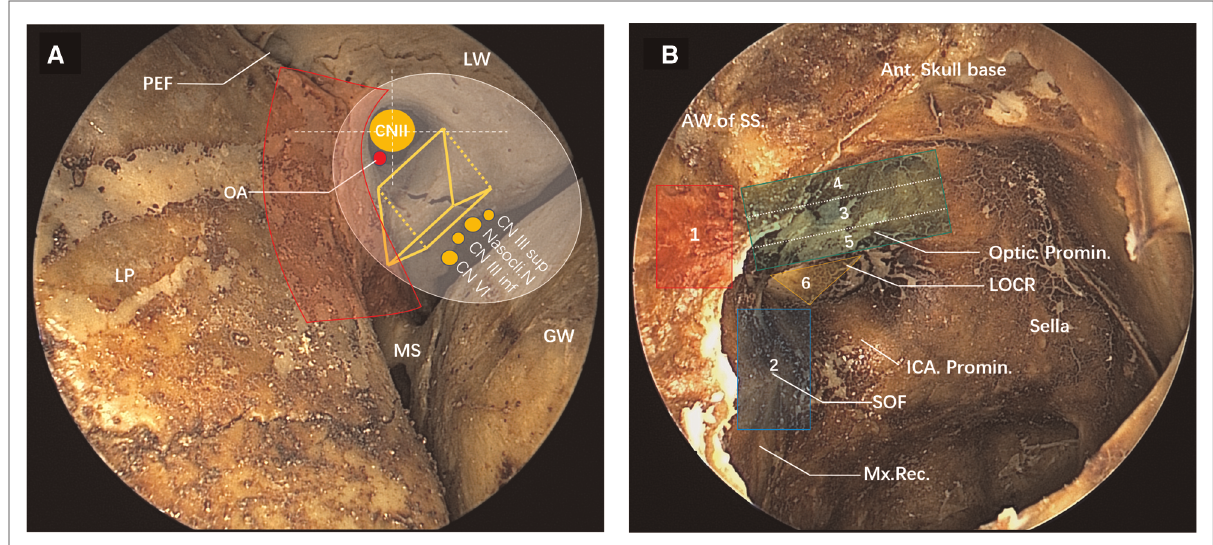
FIGURE 1 View of the superior orbital fi ssure and lateral wall of the sphenoid sinus on the dried skull under the nasal endoscope. ( A ) Transorbital view of the partial superior orbital fi ssure (left). The medial margin of superior orbital fracture consists, from top to bottom, of the lateral surface of the optic strut (optic strut fractures shown in the fi gure), part of the body of the sphenoid bone and the maxillary strut. The lateral margin of the superior orbital fi ssure consists of the great wing of the sphenoid bone. The optic strut can be seen as a triangular prism structure (yellow triangular prism structure in the fi gure), with its superior bottom connected to the small wing of the sphenoid bone and its inferior bottom connected to the body of the sphenoid bone, jointly forming an optic canal, through which the optic nerve and the ophthalmic artery pass. The optic canal is divided into four quadrants by white dotted lines, and the ophthalmic artery enters the orbit from the right lower quadrant. The lateral wall of the optic strut is adjacent to the nerves emerging from the cavernous sinus, namely the superior branch of the oculomotor nerve, the nasociliary nerve, the inferior branch of the oculomotor nerve and the abducent nerve from top to bottom, and they enter the orbit through the common tendinous ring (white area). The red area is the range of decompression of the optic canal, the superior orbital fi ssure and the orbital apex. Posterior ethmoidal foramen can be seen on the medial wall of the roof of the orbit, and the medial wall of the orbit is the lamina papyracea. ( B ) View of the lateral wall of the sphenoid sinus under the nasal endoscope (right). The yellow triangle area is the inferior bottom of the optic strut in a triangular prism structure (LOCR). The optic nerve prominence, the superior orbital fi ssure (blue area) and the ICA prominence form the three sides of the optic strut triangle. The red area is the approximate range of decompression of the orbital apex. The superior orbital fi ssure (overall blue area) is adjacent inferiorly to the maxillary strut depression, and superiorly to the optic strut. The residual anterior wall of the sphenoid sinus following sphenoidostomy is shown on the left side of the view. The order of the decompression of the oculomotor nerve fi ssure segment is as follows: (1) orbital apex, (2) superior orbital fi ssure, (3) inferomedial wall of the optic canal, (4) superior wall of the optic canal, (5) inferior wall of the optic canal, and (6) optic